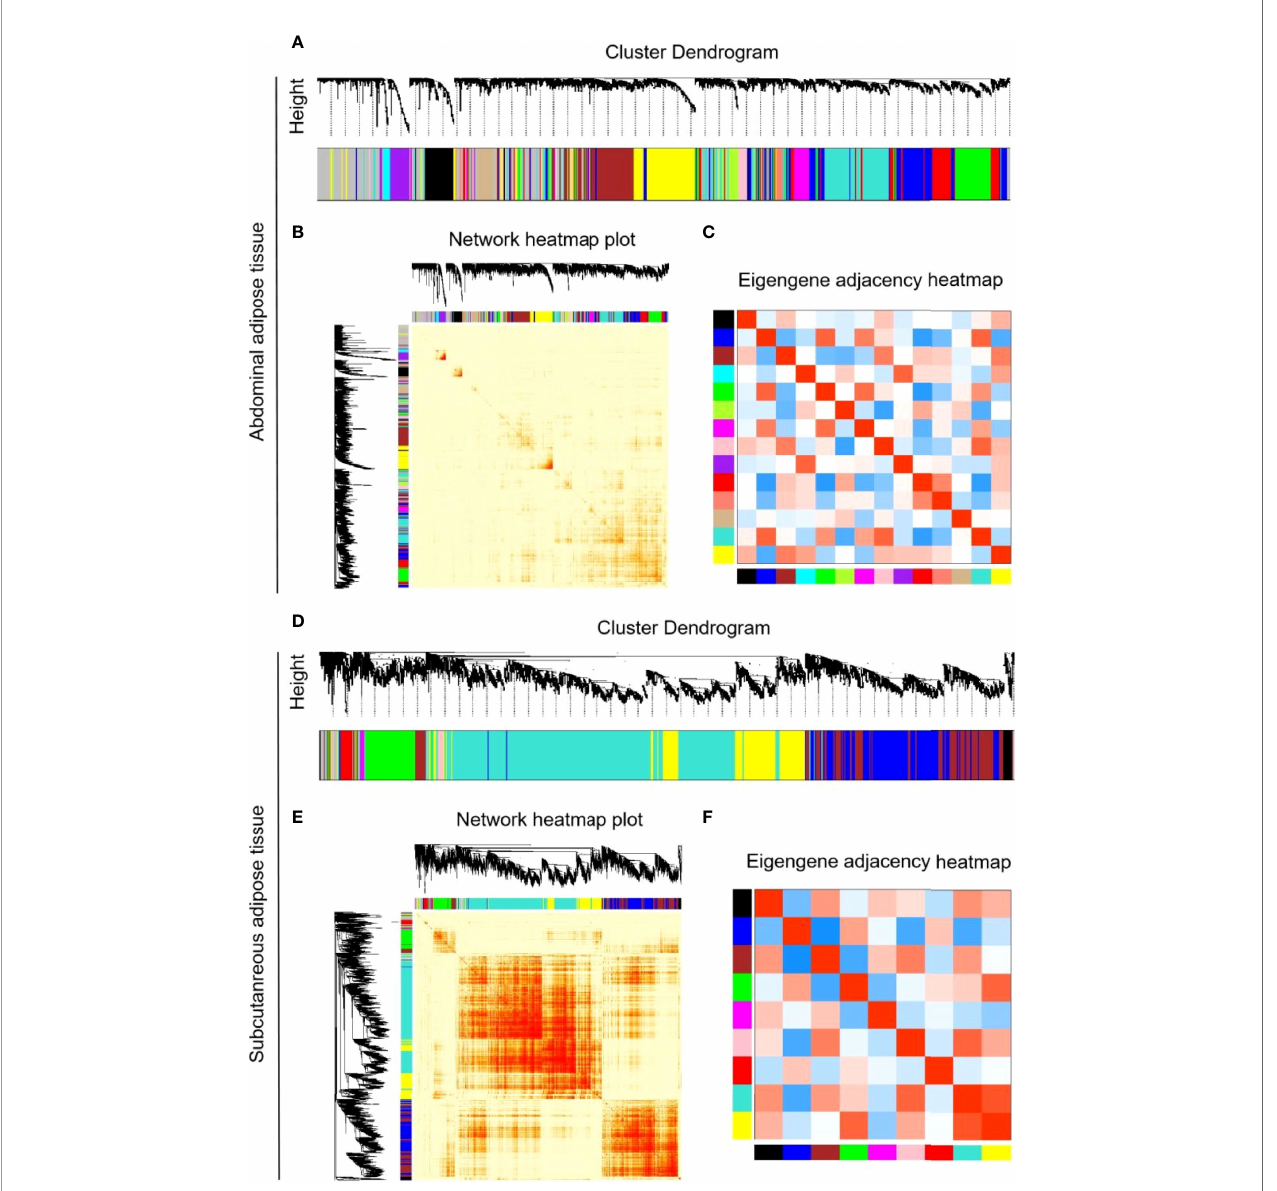
FIGURE 6 | WGCNA parameters of RNA-Seq library of chick subcutaneous and abdominal adipose tissues from embryonic to post-hatch development. (A) Cluster dendrogram of RNA-Seq library of chick abdominal adipose tissue in fi ve development stages; (B) network heatmap of RNA-seq library of chick abdominal adipose tissue in fi ve development stages; (C) eigengene adjacency heatmap of RNA-seq library of chick abdominal adipose tissue in fi ve development stages; (D) cluster dendrogram of RNA-seq library of chick subcutaneous adipose tissue in four development stages; (E) network heatmap of RNA-seq library of chick subcutaneous adipose tissue in four development stages; (F) eigengene adjacency heatmap of RNA-Seq library of chick subcutaneous adipose tissue in four development